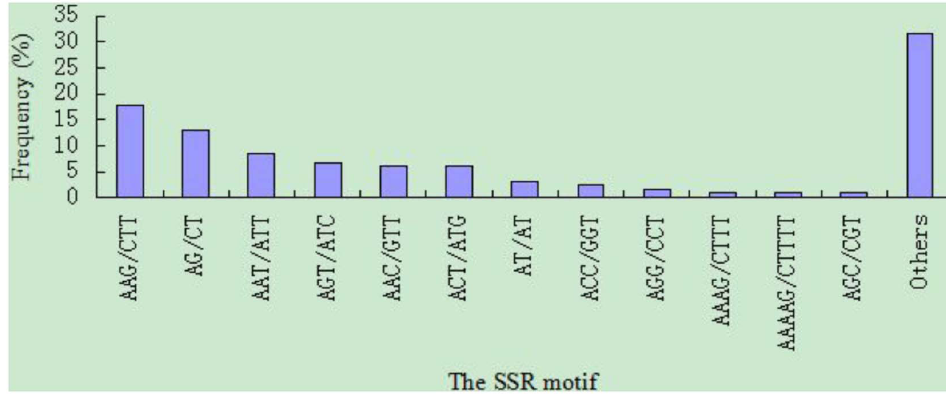
Figure 1. Frequency distribution of cannabis EST-SSR based on motif numbers.